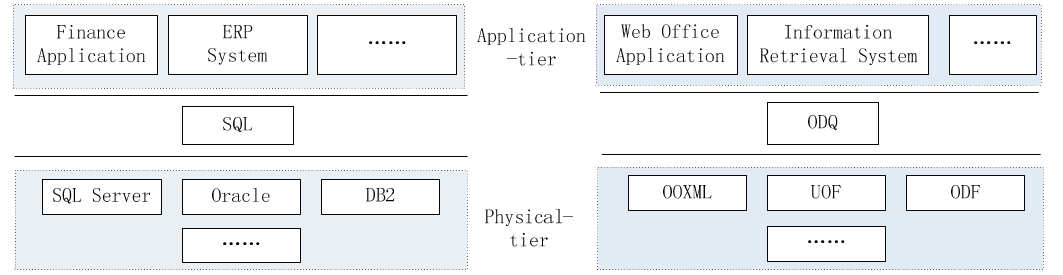
Figure 1. Structured query language (SQL) vs . office document query